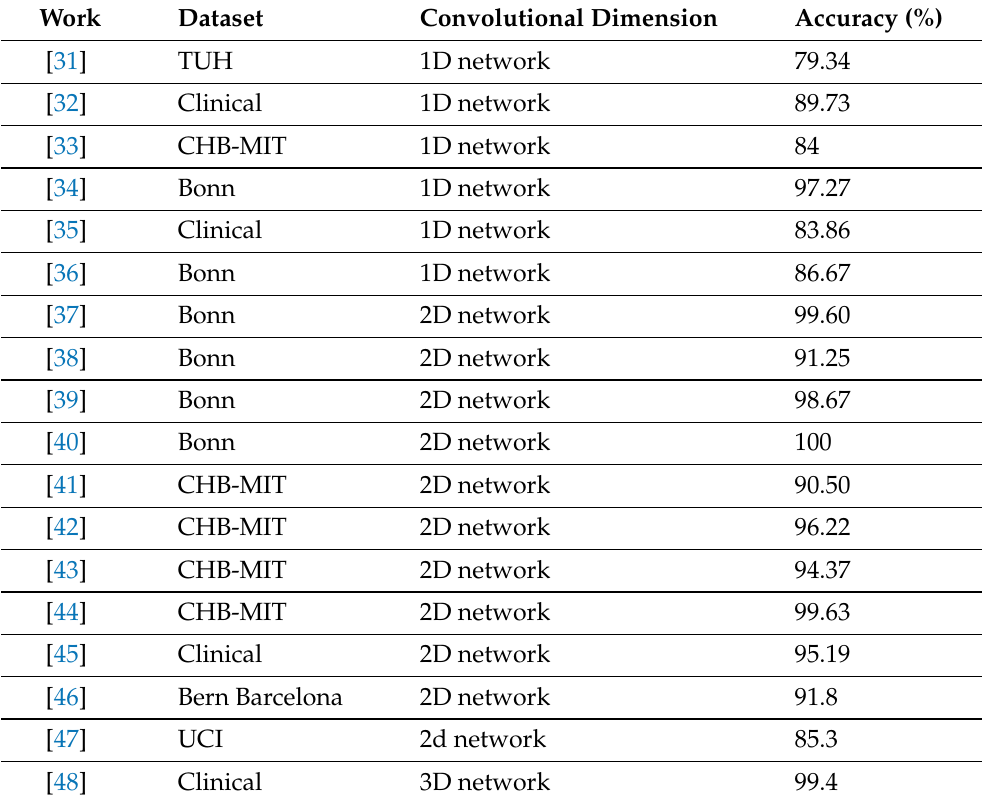
Table 1. Neural networks with different convolutional dimensions